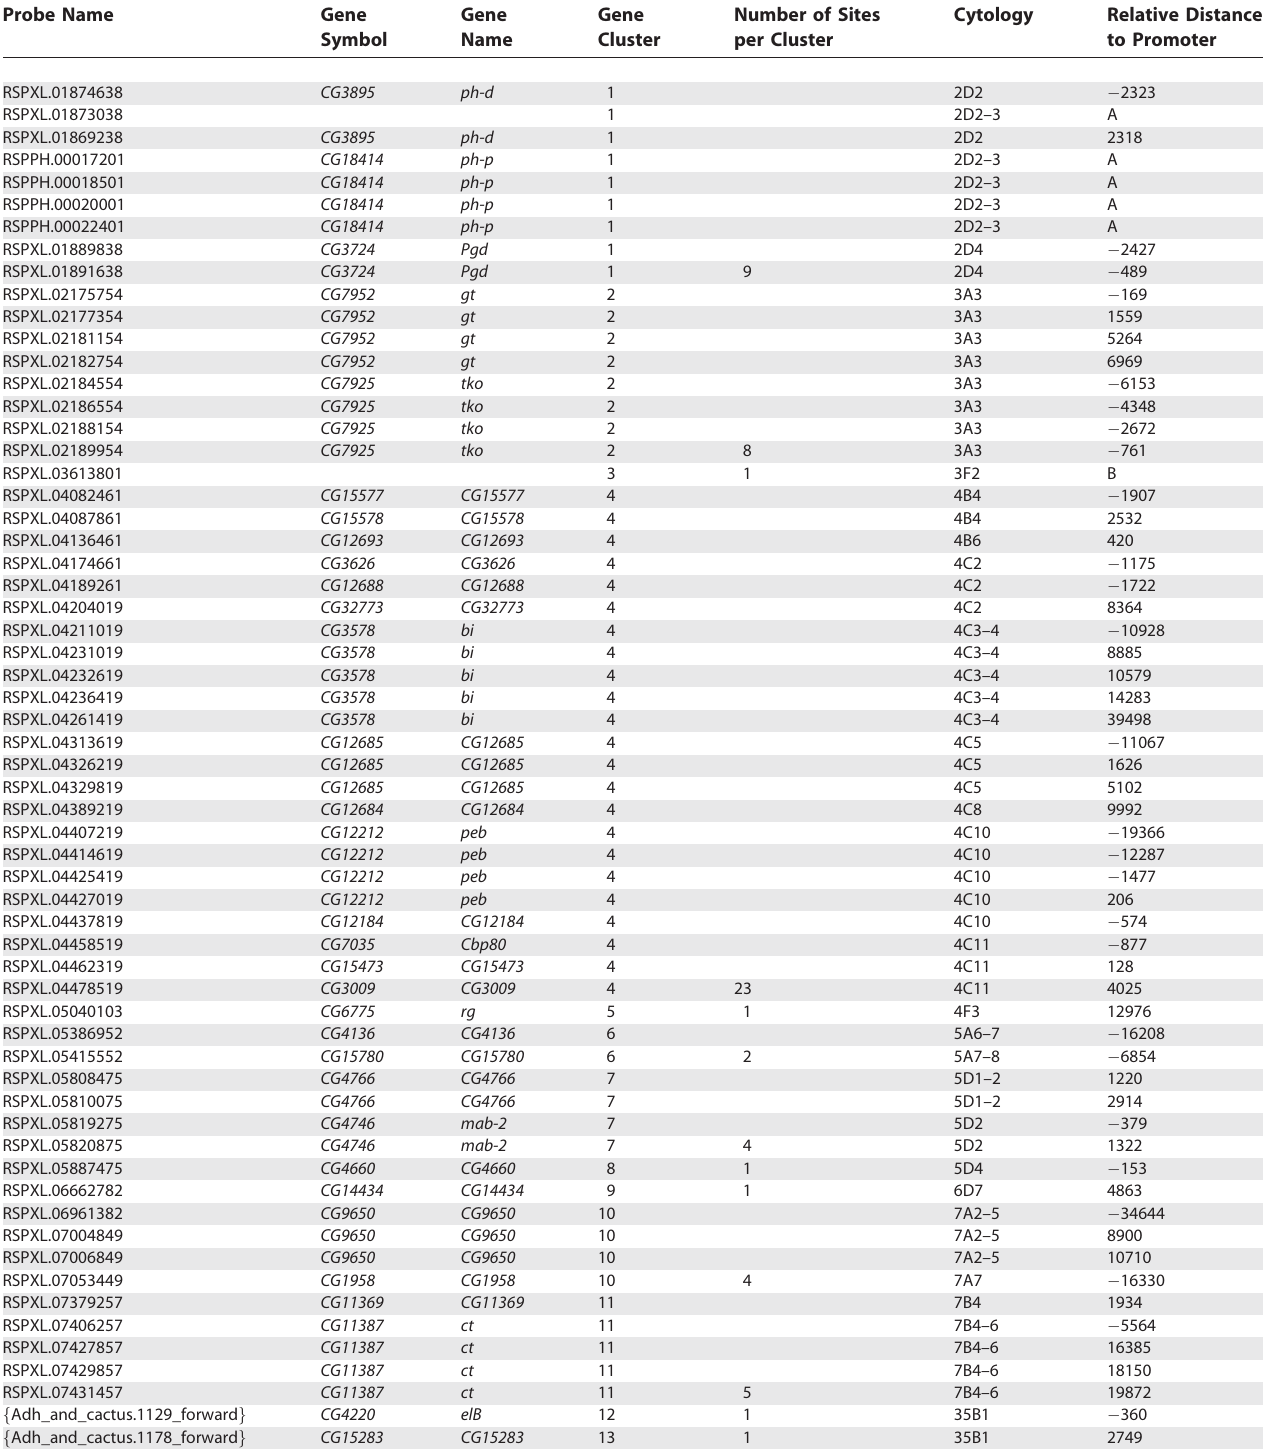
Table 2. Genomic Distribution of PRC1 Binding